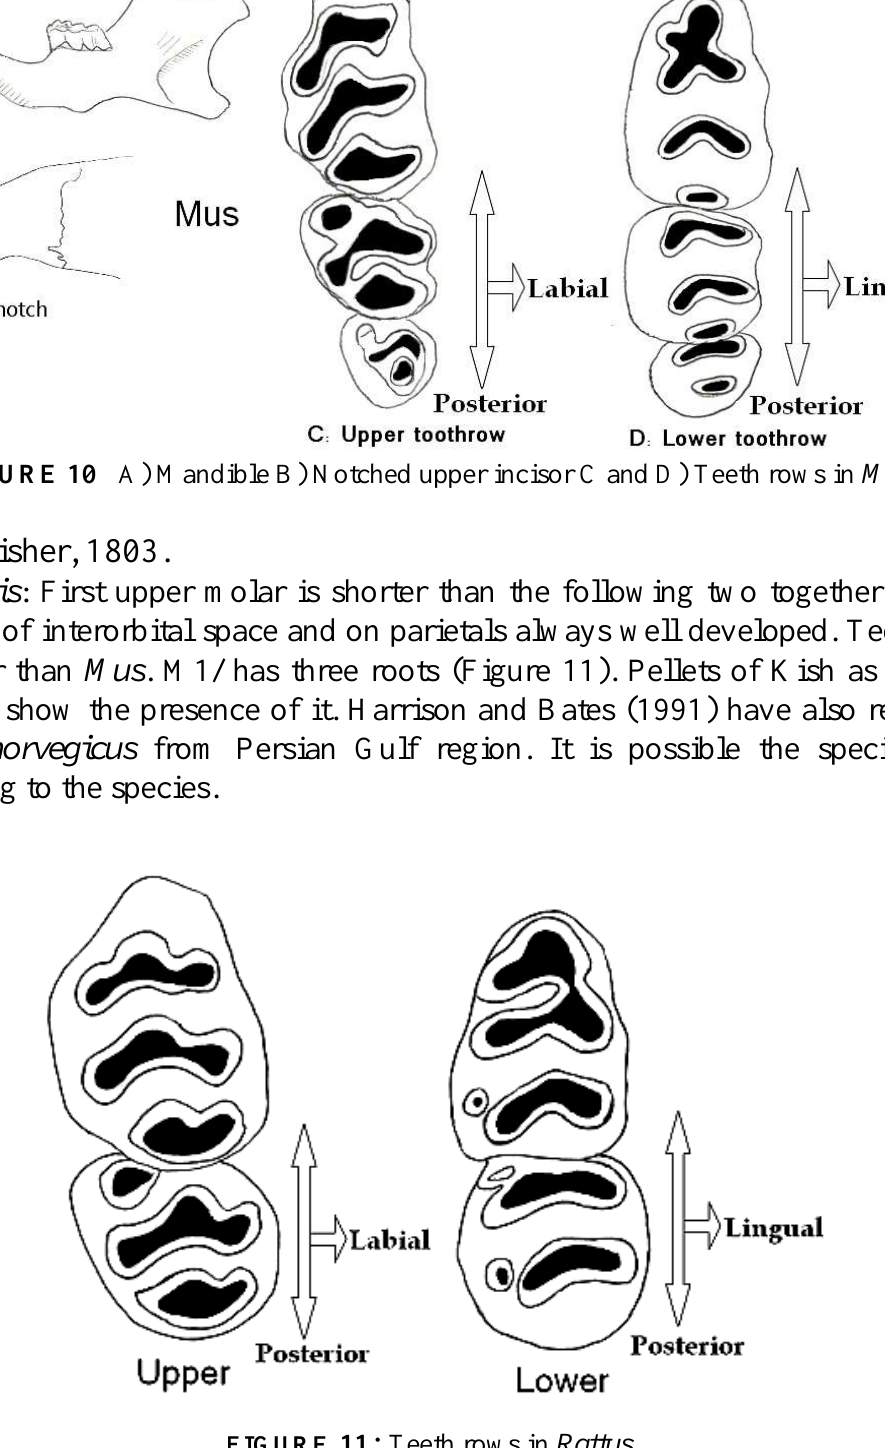
FIGURE 11 : Teeth rows in Rattus